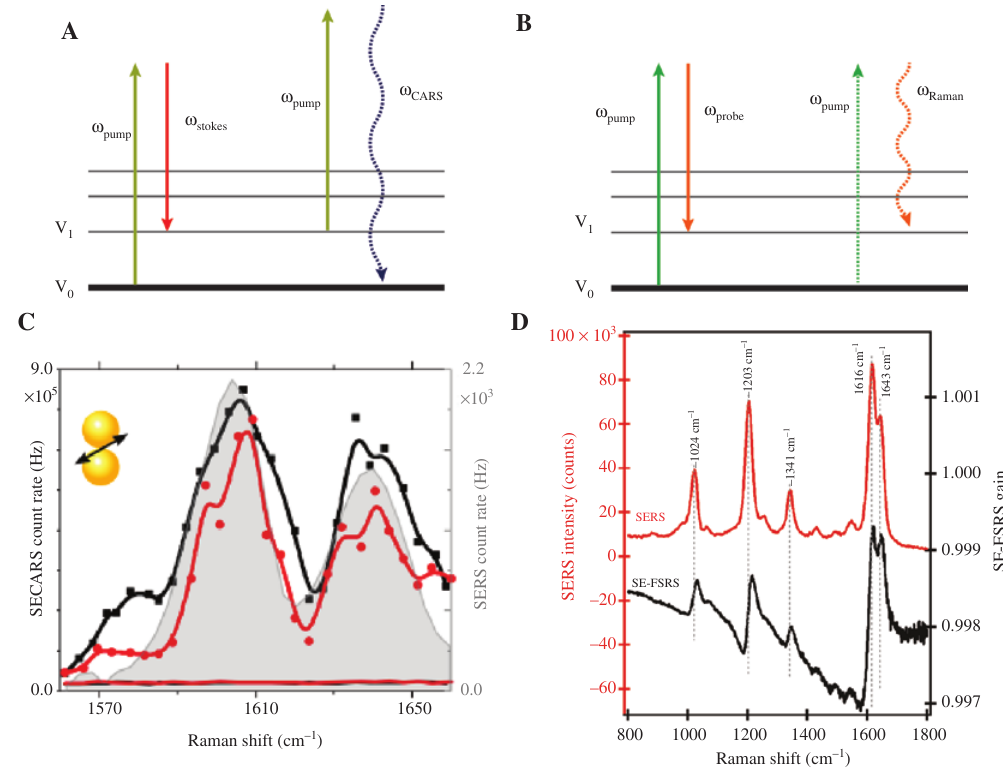
Figure 9: Surface-enhanced coherent Raman spectroscopies. Energy diagram depicting the photon interactions leading to the generation of surface-enhanced (A) CARS and (B) FSRS signal. (B) Comparison of ps-SE-CARS spectra (red and black traces) and cw-SERS spectra (gray, shaded peaks). (D) Raman spectra of BPE using cw-SERS (red) and SE-FSRS (black). (C) Reprinted with permission from Ref. [136]. Copyright 2016 American Chemical Society. (D) Reprinted with permission from Ref. [142]. Copyright 2017 American Chemical